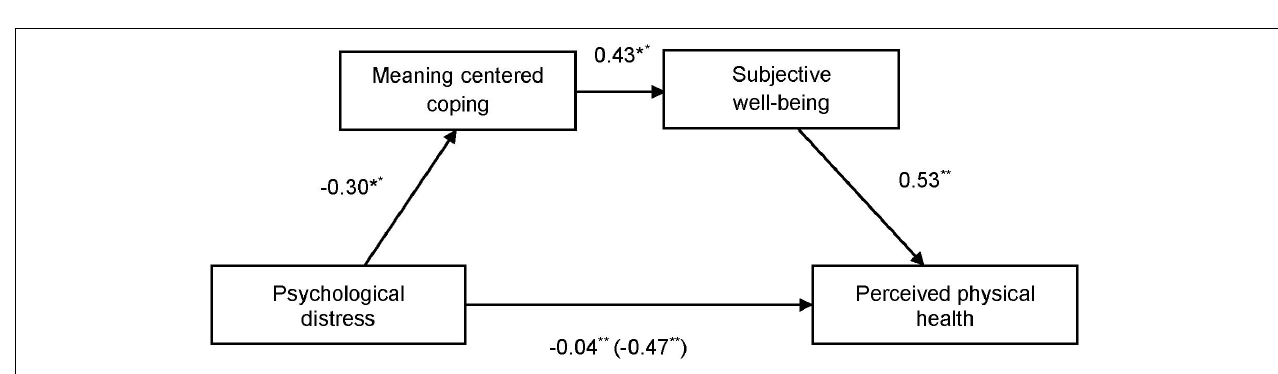
FIGURE 3 | Sequential mediation analysis of meaning centered coping (serial mediator 1) and subjective well-being (serial mediator 2) in the relation between psychological distress and perceived physical health. Direct effects after including the mediator are in brackets. ** p ≤ 0.001; * p ≤